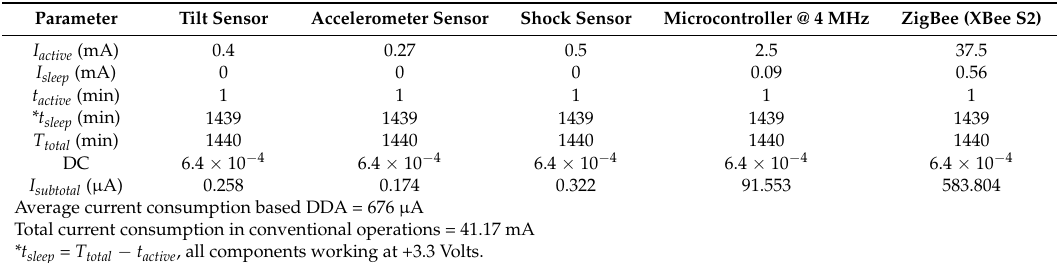
Table 2. Current and time consumption of each component of the